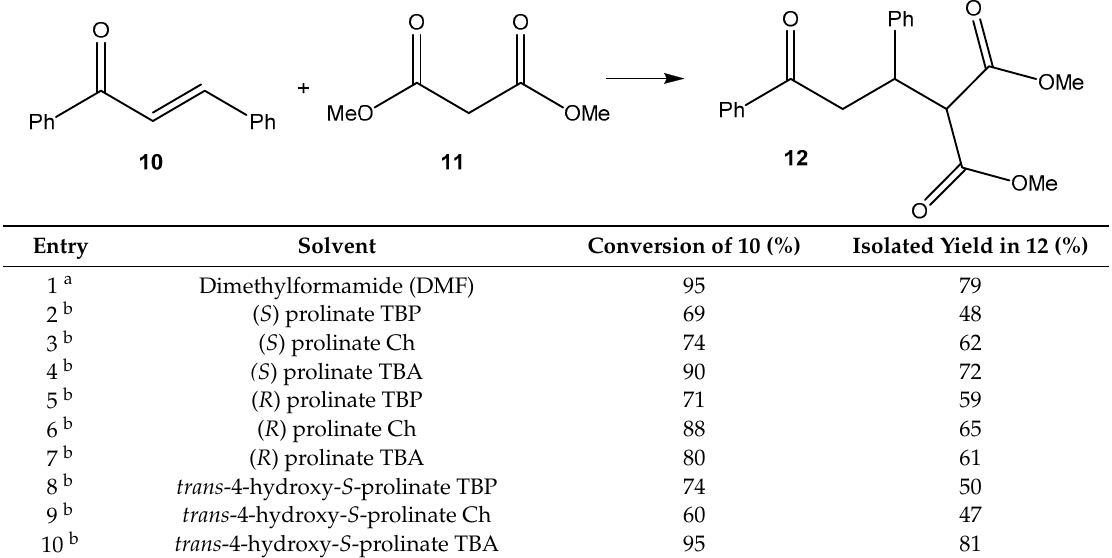
Table 4. Michael’s reaction under